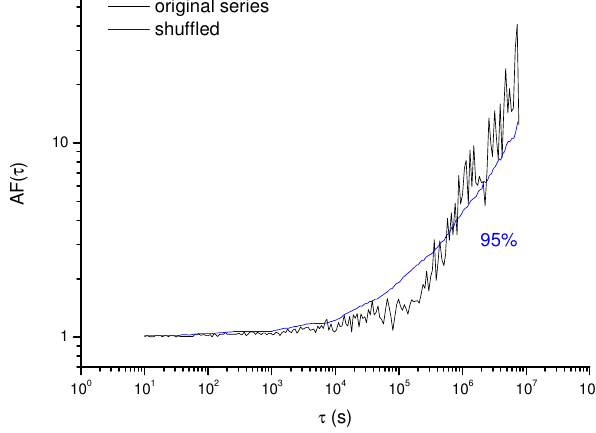
Fig. 8. Comparison between the AF of the cluster a and the 95% confidence curve evaluated over 1000 Poisson surrogates.